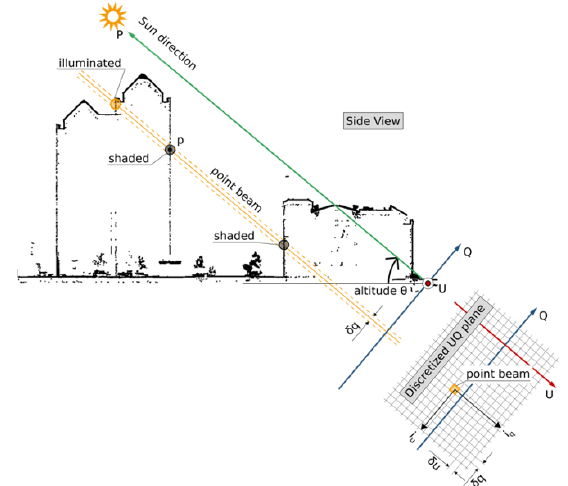
Figure 1. Distributed shadow computation